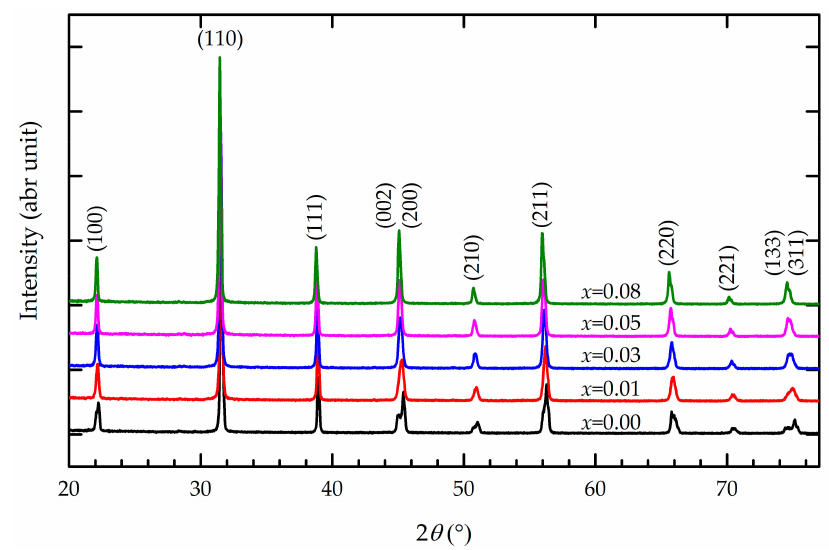
Figure 2. XRD patterns of the Ba(Zr x Ti 1 − x )O 3 ceramics.